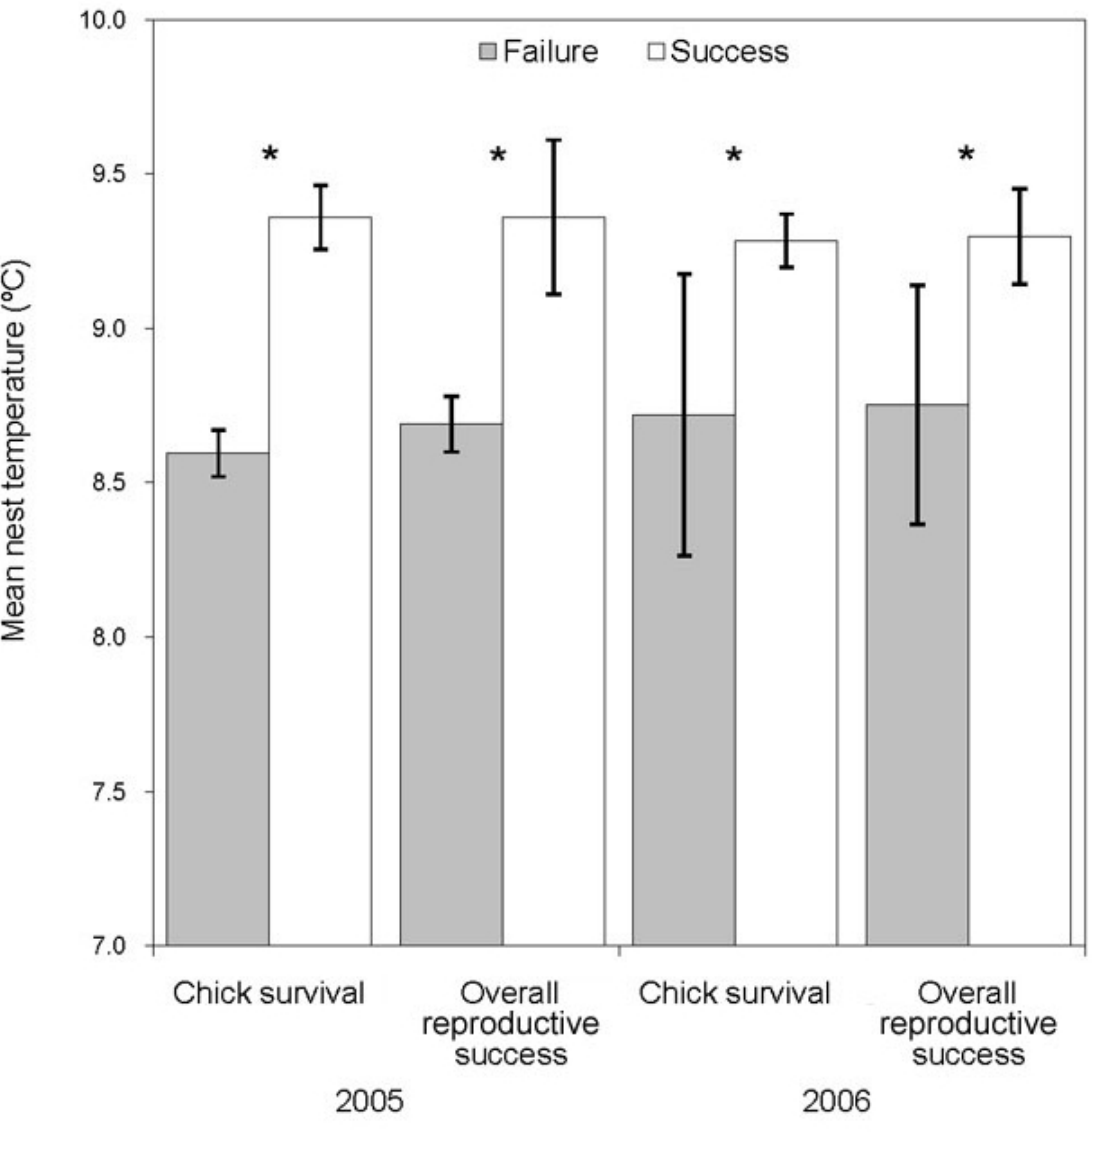
Fig. 2 . Mean (± 95% CI) nest temperature (°C) in relation to chick survival and overall reproductive success in Fork-tailed Storm-Petrel ( Oceanodroma furcata ) nests on Kasatochi Island, Alaska in 2005 and 2006. Asterisks indicate significant differences ( P < 0.05) between success (white bars) and failure (grey